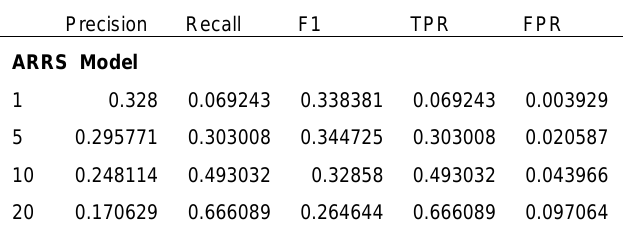
Table 3. Experimental results accuracy of two models on binary dataset.